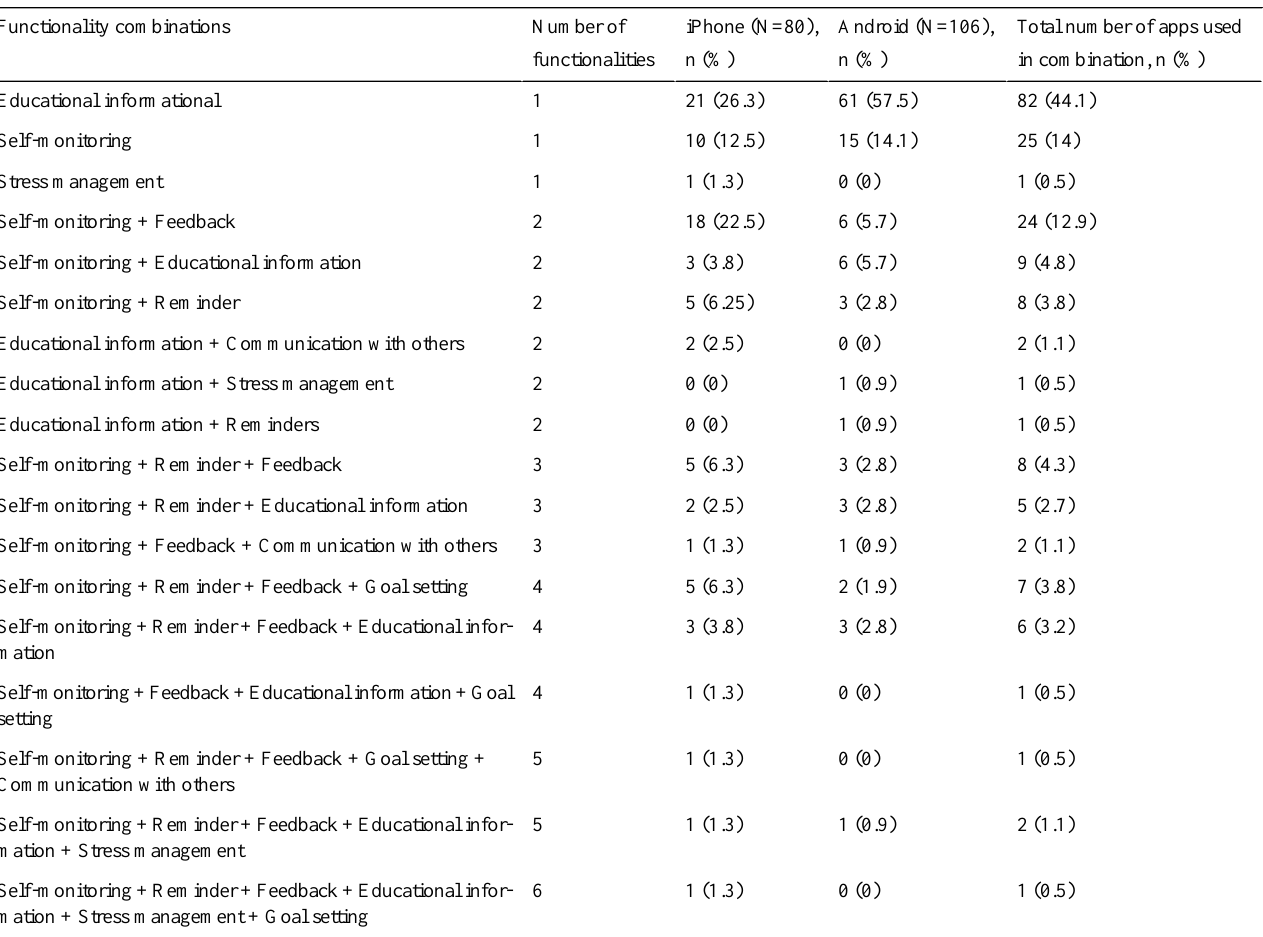
Table 2. Common combinations of app functionalities.